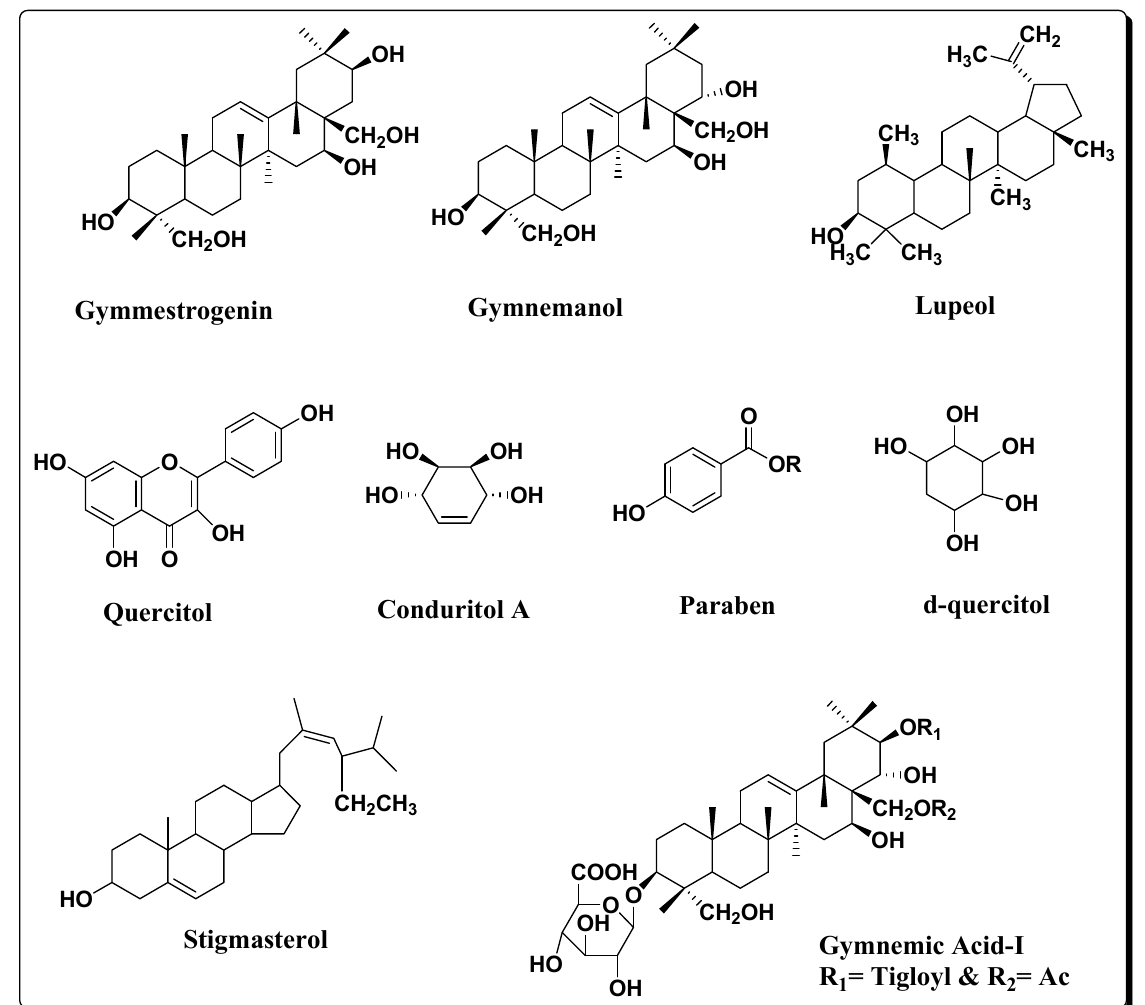
Figure 1. Phytochemical constituents in Gymnema sylvestre .